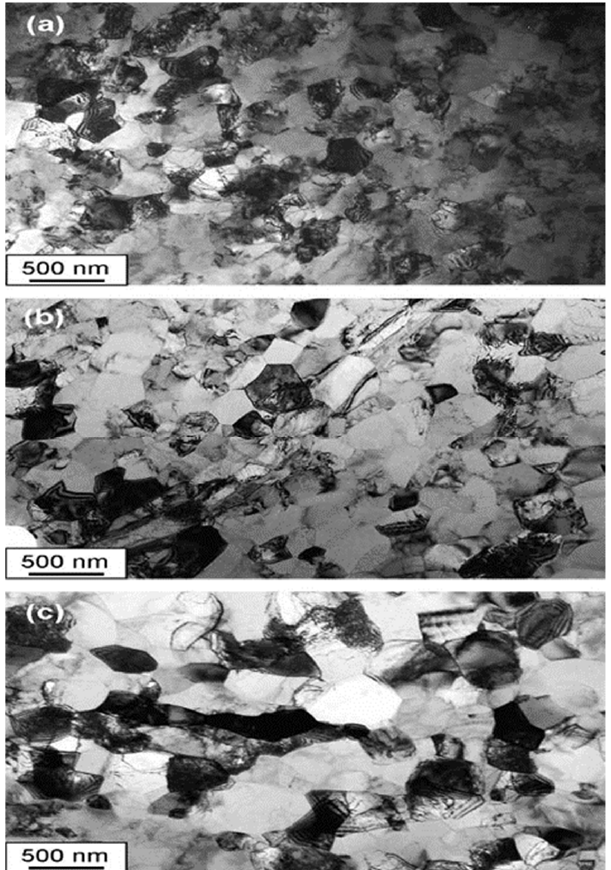
Figure 7. Bright-field TEM micrographs of the Ti 49.4 Ni 50.6 alloy processed by the ECAP method at ( a ) 400 °C for eight passes, ( b ) 500 °C for twelve passes, and ( c ) 450 °C for eight passes and subsequent annealing at 550 °C for 1 h, adapted with permission from [61], 2022, Elsevier.